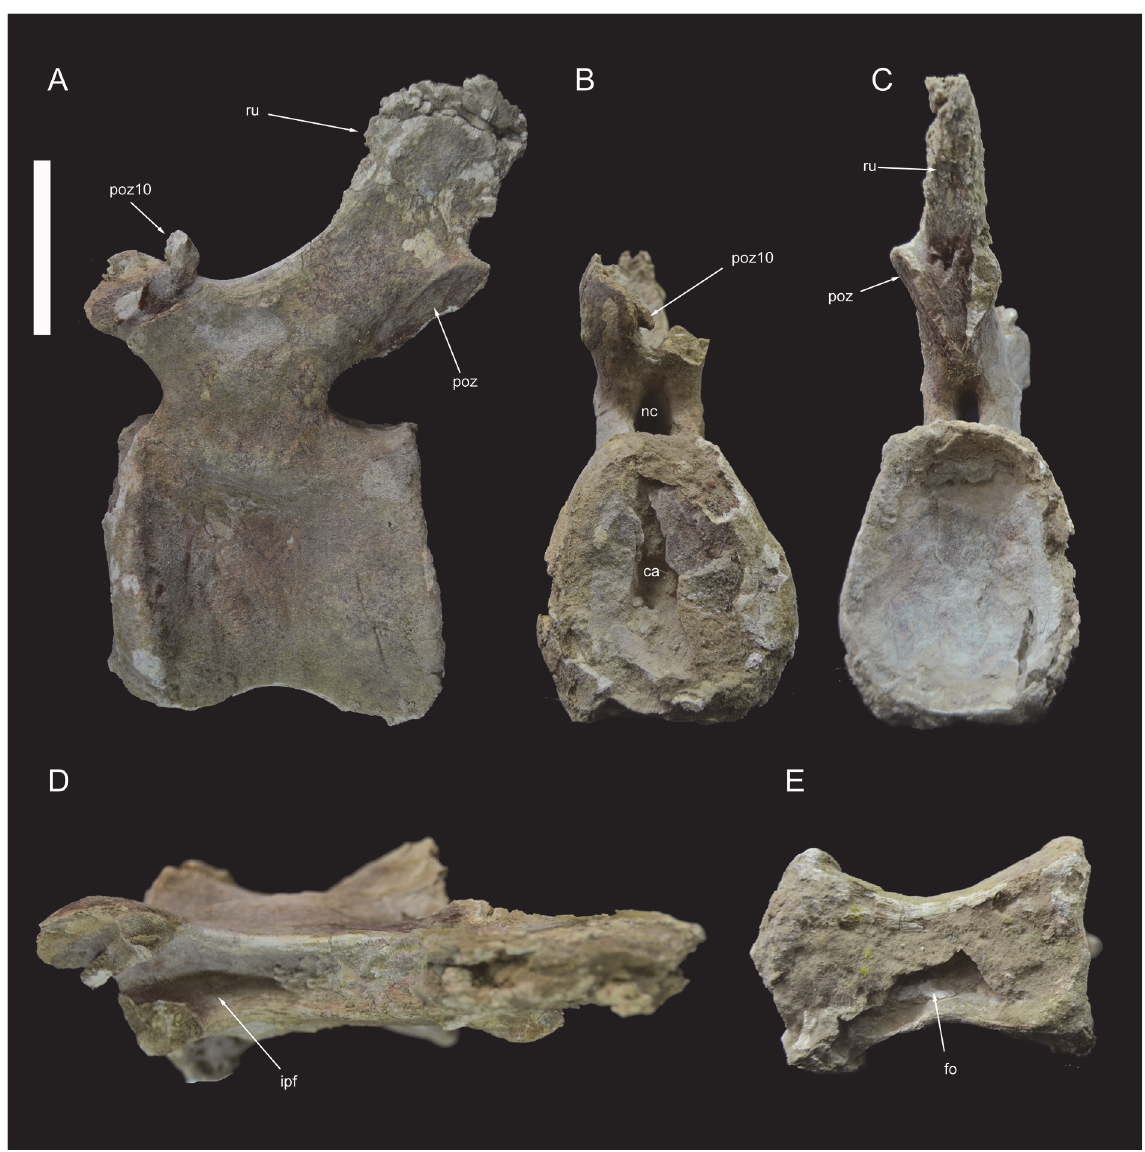
Fig 13. Caudal vertebra 11 of Tataouinea hannibalis . Vertebra in left lateral (A), proximal (B), distal (C), dorsal (D) and ventral (E) views. Scale bar: 10 cm. Abbreviation: ca, camerae; fo, fossa; ipf, interprezygapophyseal fossa; nc, neural canal; poz, postzygapophysis; poz10, fragment of caudal 10 right postzygapophysis; ru,